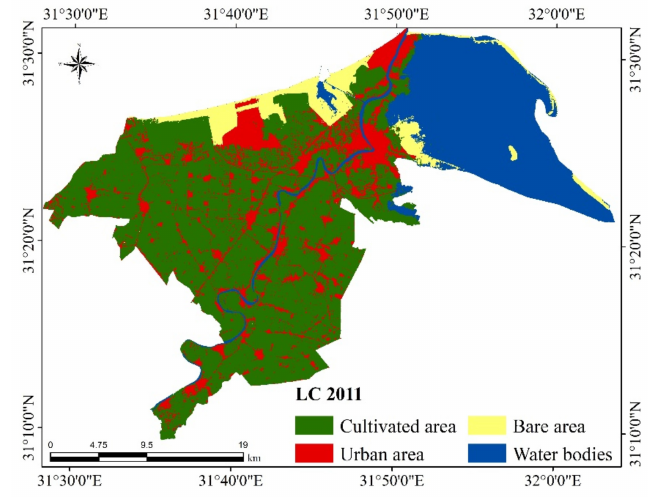
Figure 5. LULC of Damietta governorate at 2011.